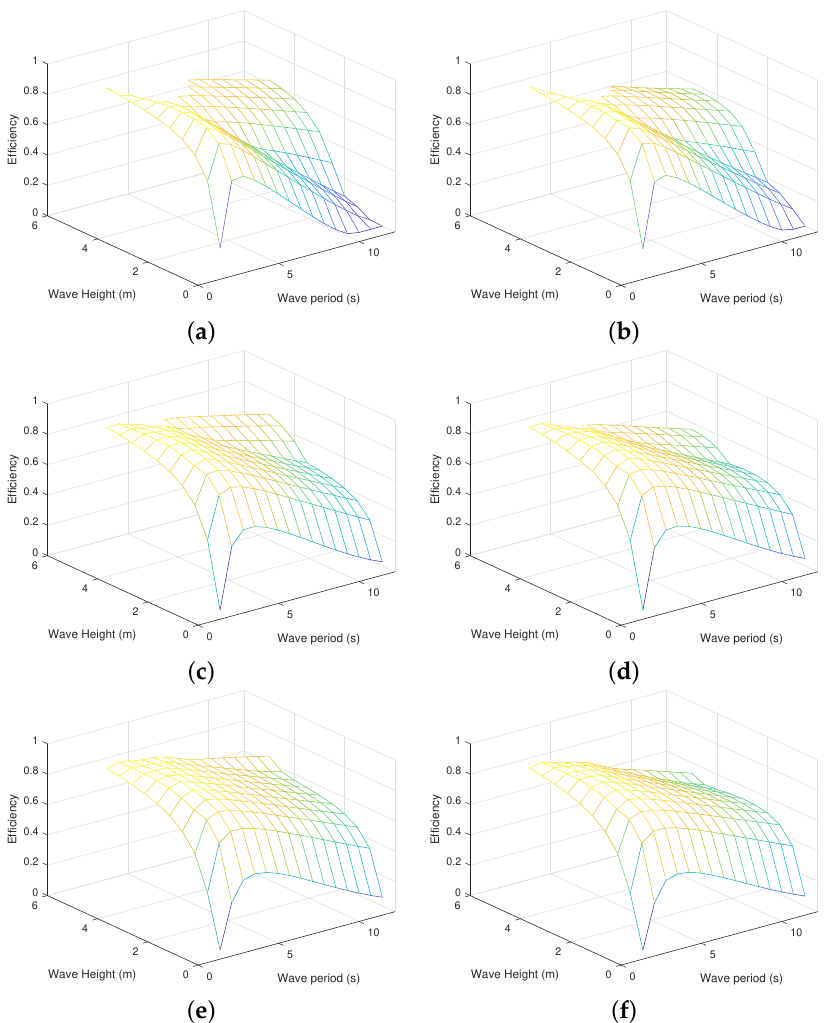
Figure 6. Comparison between efficiency maps of generators scaled based on different methods. ( a ) Designed maximum force is 100 kN, based on method 1. ( b ) Designed maximum force is 100 kN, based on method 2. ( c ) Designed maximum force is 160 kN, based on method 1. ( d ) Designed maximum force is 160 kN, based on method 2. ( e ) Designed maximum force is 200 kN, based on method 1. ( f ) Designed maximum force is 200 kN, based on method